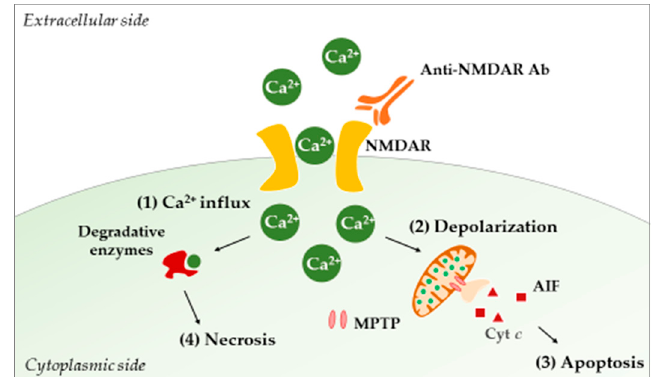
Figure 3. Acute excitotoxicity in NPSLE. The binding of anti-NMDAR Abs to NMDAR allows the free entry of calcium ions ( 1 ). Intracellularly, the ions are taken up by mitochondria in order to buffer incoming calcium, leading to increased cellular respiration and ROS production. Concomitant with the increase in calcium concentration, the mitochondrial membrane potential collapses, and MPTPs open ( 2 ). Consequently, proapoptotic molecules (e.g., Cyt c , AIF) are released, and apoptosis (controlled neuronal death) occurs ( 3 ). On the other hand, calcium can activate cytosolic enzymes (e.g., phospholipases, proteases, endonucleases) that will damage neurons intracellularly, leading to necrosis ( 4 ). Abbreviations: Ab, antibody; AIF, apoptosis-inducing factor; Cyt c , cytochrome c ; MPTP, mitochondrial permeability transition pore; NMDAR, N-methyl- D -aspartate receptor; ROS, reactive oxygen species.